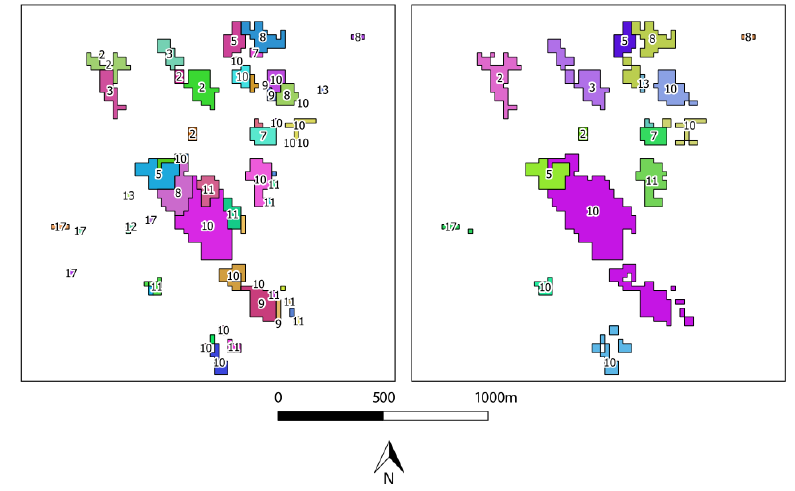
Figure 4. Example of creation of the FCLE by aggregating polygons to represent contiguous harvesting sites and eliminating fragmented small stands. Numbers report the year of harvest after the year 2000, originally recorded (FCL map, left ) and retained after thresholding and aggregation (FCLE map, right ).